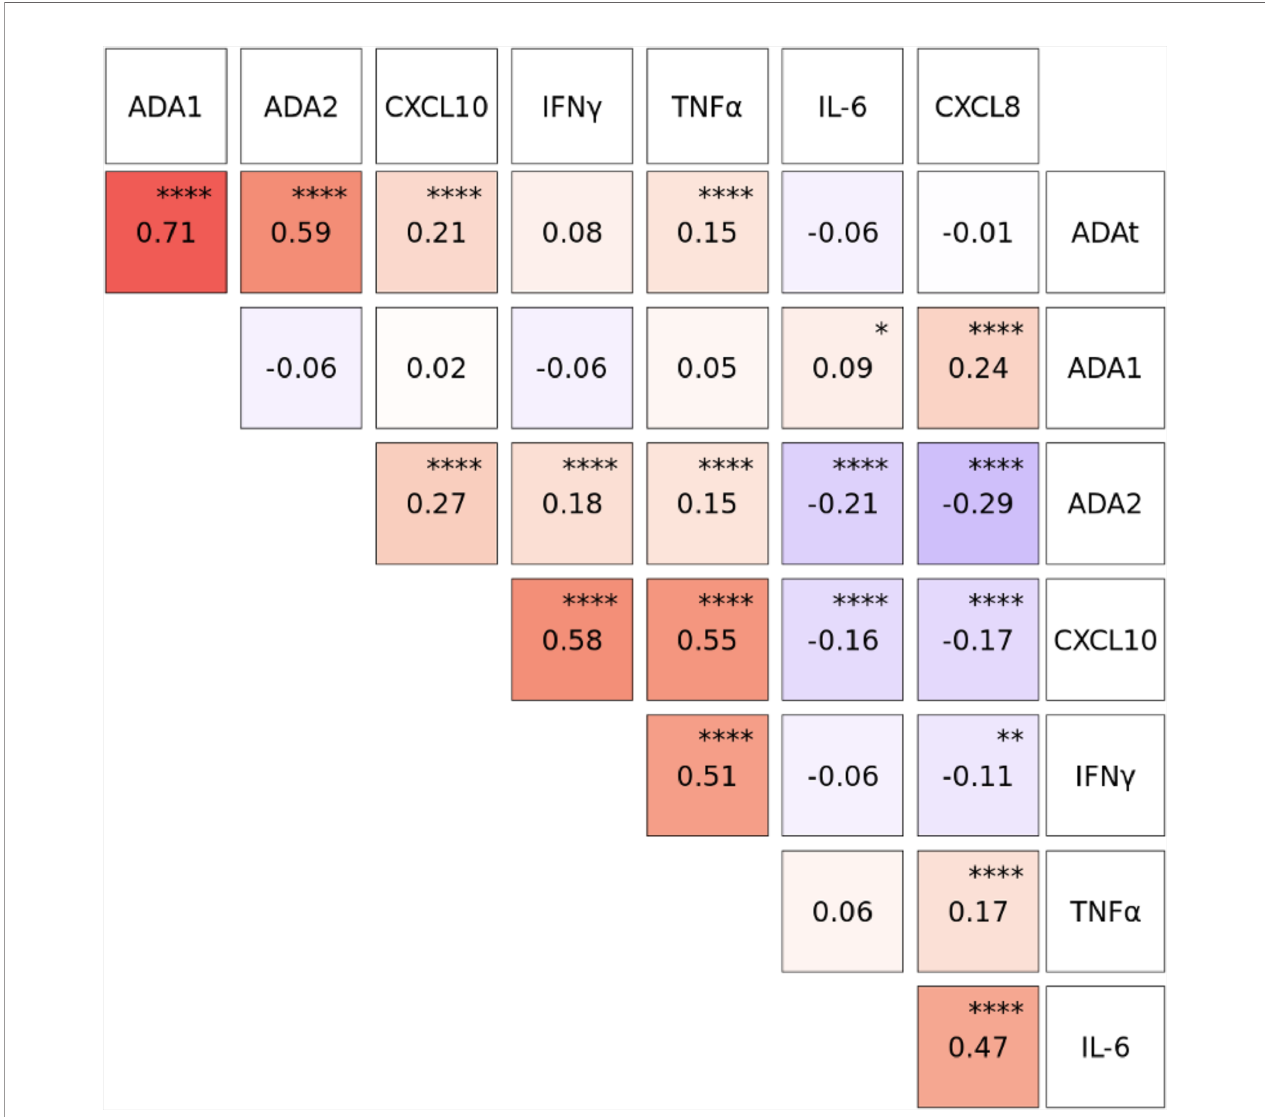
FIGURE 6 | Plasma concentrations of CXCL10, IFN g and TNF a were positively correlated with Total ADA (ADAt) and ADA2 during the fi rst week of life. Log 10 - transformed plasma cytokine and chemokine concentration were pooled from Visit 1 and Visit 2 during the fi rst week of life (n= 1027-1044 based on Visit 1 and Visit 2). Correlation coef fi cients between analytes were calculated using Spearman ’ s rho and plotted using the GGally package in R. Total ADA (ADAt) and ADA2, but not ADA1, were positively correlated (red) with CXCL10, IFN g and TNF a . ADA1 was positively correlated (red) with IL-6 and CXCL8 while ADA2 was negatively correlated (blue) with IL-6 and CXCL8. P-values were determined by R function cor.test, and adjusted using the Holm-Bonferroni method. Signi fi cant p-values depicted as *p<0.05, **p<0.01,